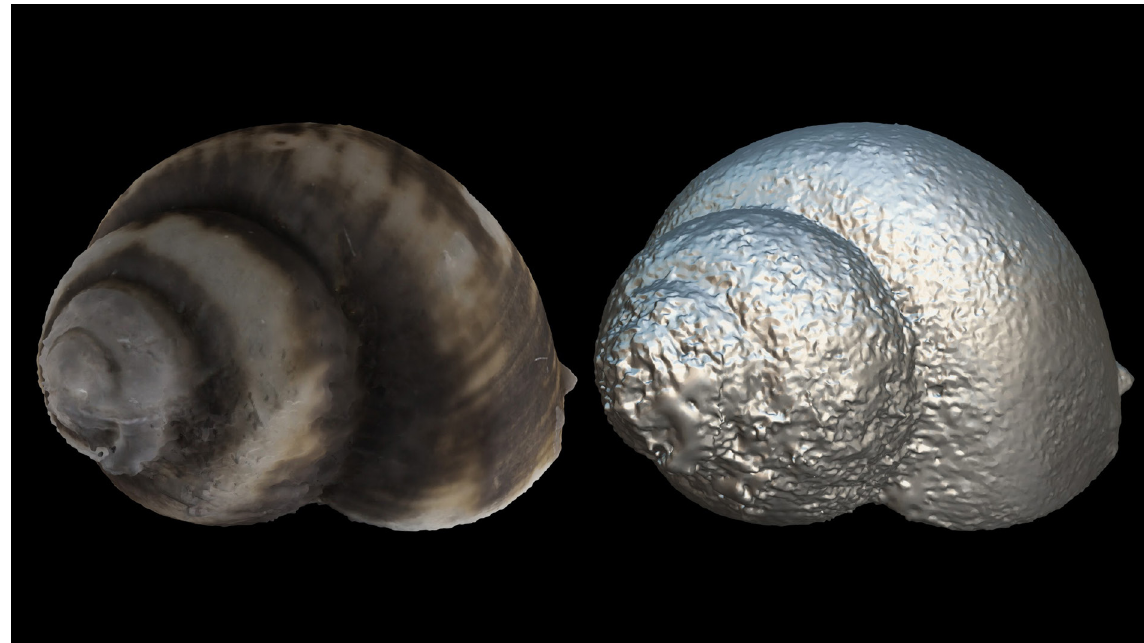
Fig. 3.11. 3D model, with texture on the left and mesh only on the right, of the mollusk Gabbiella humerosa edwardi (size: 6 mm) generated in Agisoft Photoscan based on single images (f/14).